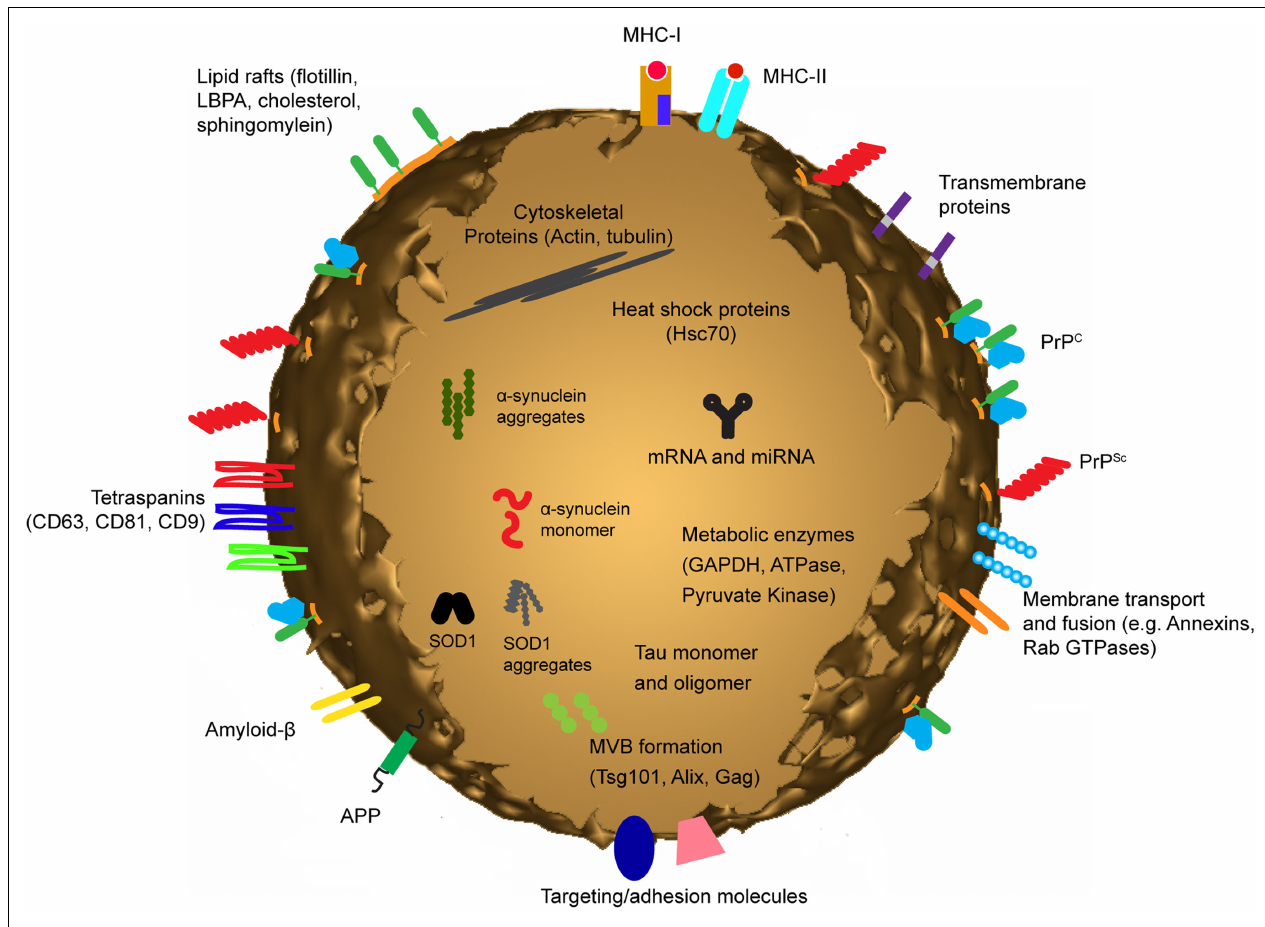
formation, tetraspanins, membrane transport and fusion and a number of cytosolic proteins. In addition to these generic proteins, proteins associated with neurodegenerative diseases such as Alzheimer’s, Prion disease, and Parkinson’s disease have been identified in exosomes.